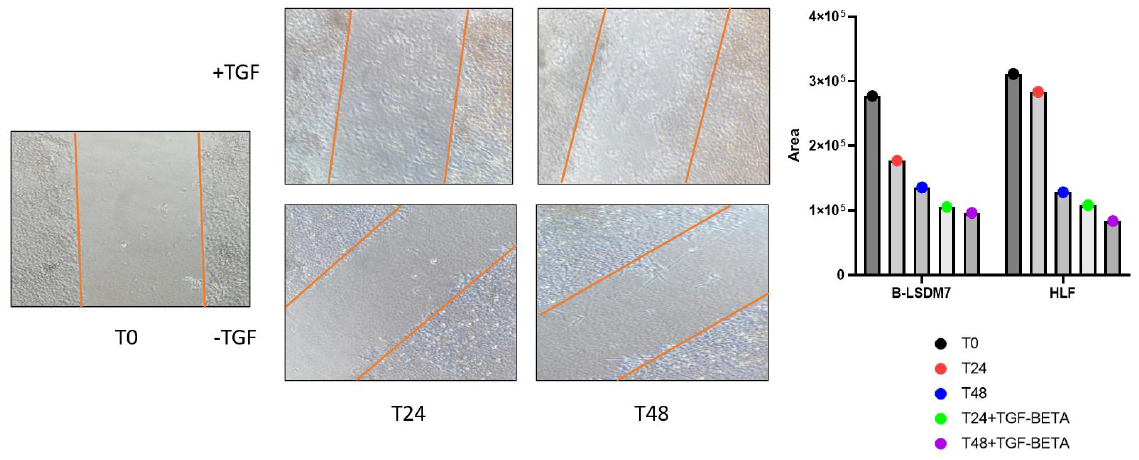
Figure 4. The inverted microscope were used for photo at time 0, 24 and 48 hours. At any timepoint, the number of cells encompassed by the lesion area was used as a parameter to define the rate of growth conditions among the experimental settings assessed. Images of cells filling the gaps were acquired 0, 24 and 48 h after generating the lesion.